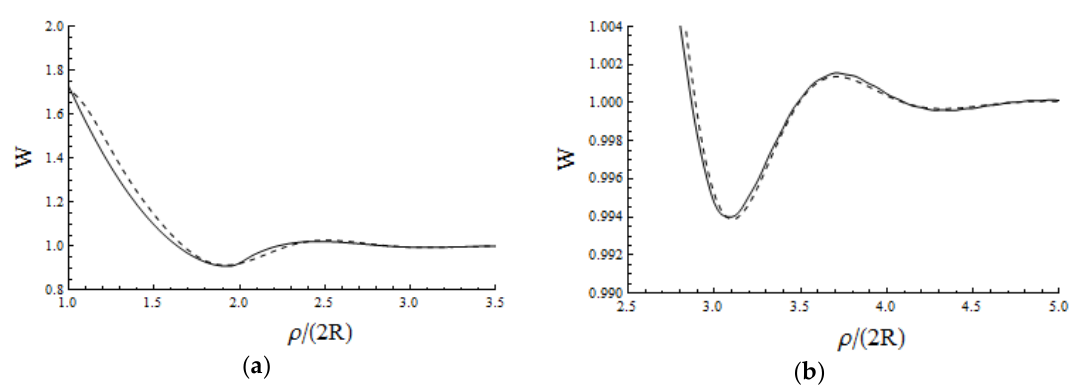
Figure 4. Radial distribution function for filling 0 . 62   { 1 , 5 }   range { 4 , 9 }   (“a tail of the distribution function”). Solid line is a solution of the Percus–Yevick equation; dashed line corresponds to the smeared lattice model.